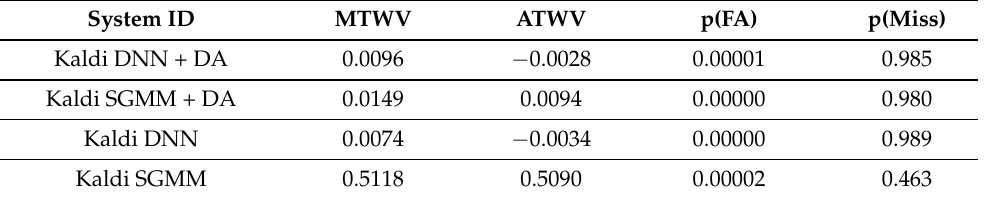
Table 12. System results of the STD task for SPARL20 test data.